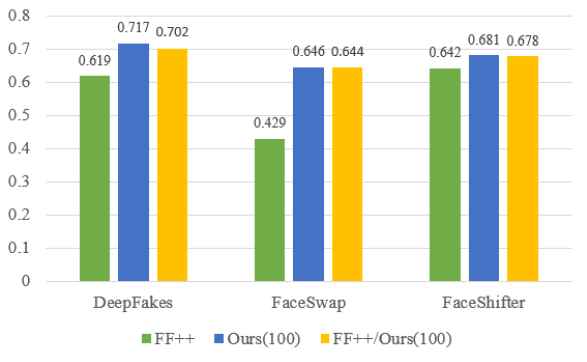
Figure 6. The testing accuracy comparison results on CelebDF-v2 of detection models trained on different datasets. The training data generated by our method provides better temporal coherence and quality which is challenging for detection and is able to help promote the ability of detection